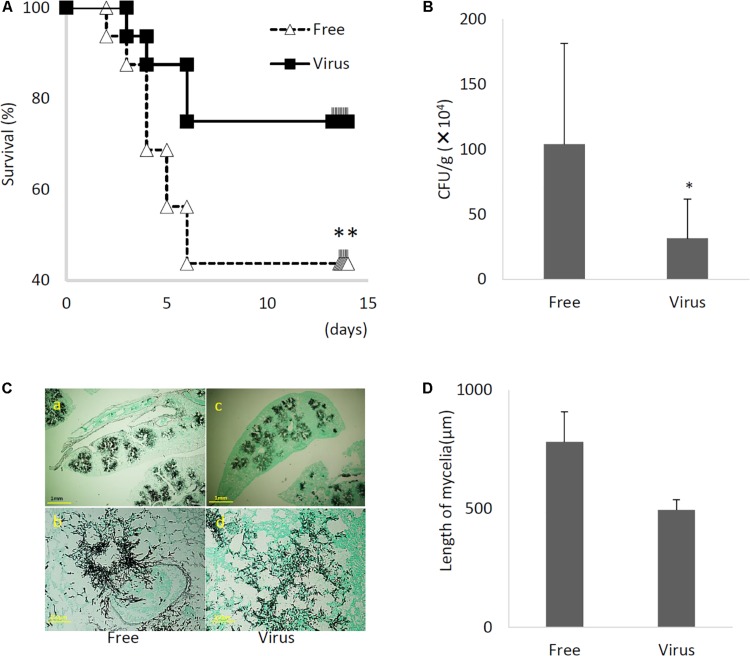
Comparisons of murine virulence of virus-free (Free) and virus-infected (Virus) strains. (A) Survival rates of mice infected with the AfuCV41362 virus-infected and virus-free strains. ∗∗P < 0.05 by Kaplan–Meier log tank test. (B) Fungal growth from the lungs of infected mice. Fungal burdens were estimated as CFUs per gram of lung. Five mice per experiments and repeated three times. (C) Lung histology of mice at 3 days after infection (Gomori’s methenamine silver-staining-Grocott’s variation). (a,b) virus-free strains; (c,d) virus-infected strains. (D) Quantified mycelial growth in the lungs of mice infected with the virus-free and virus-infected fungal strains. The tissues were dissected for observation on day 3 after infection. For graphs B and D, data are presented as mean + SD of three independent experiments. ∗P < 0.05, by two-tailed Student’s t-test.